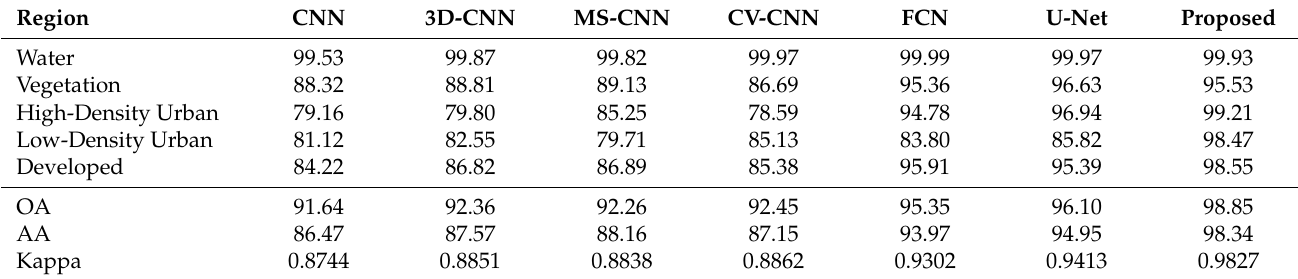
Table 9. Classification results of different methods in the San Francisco